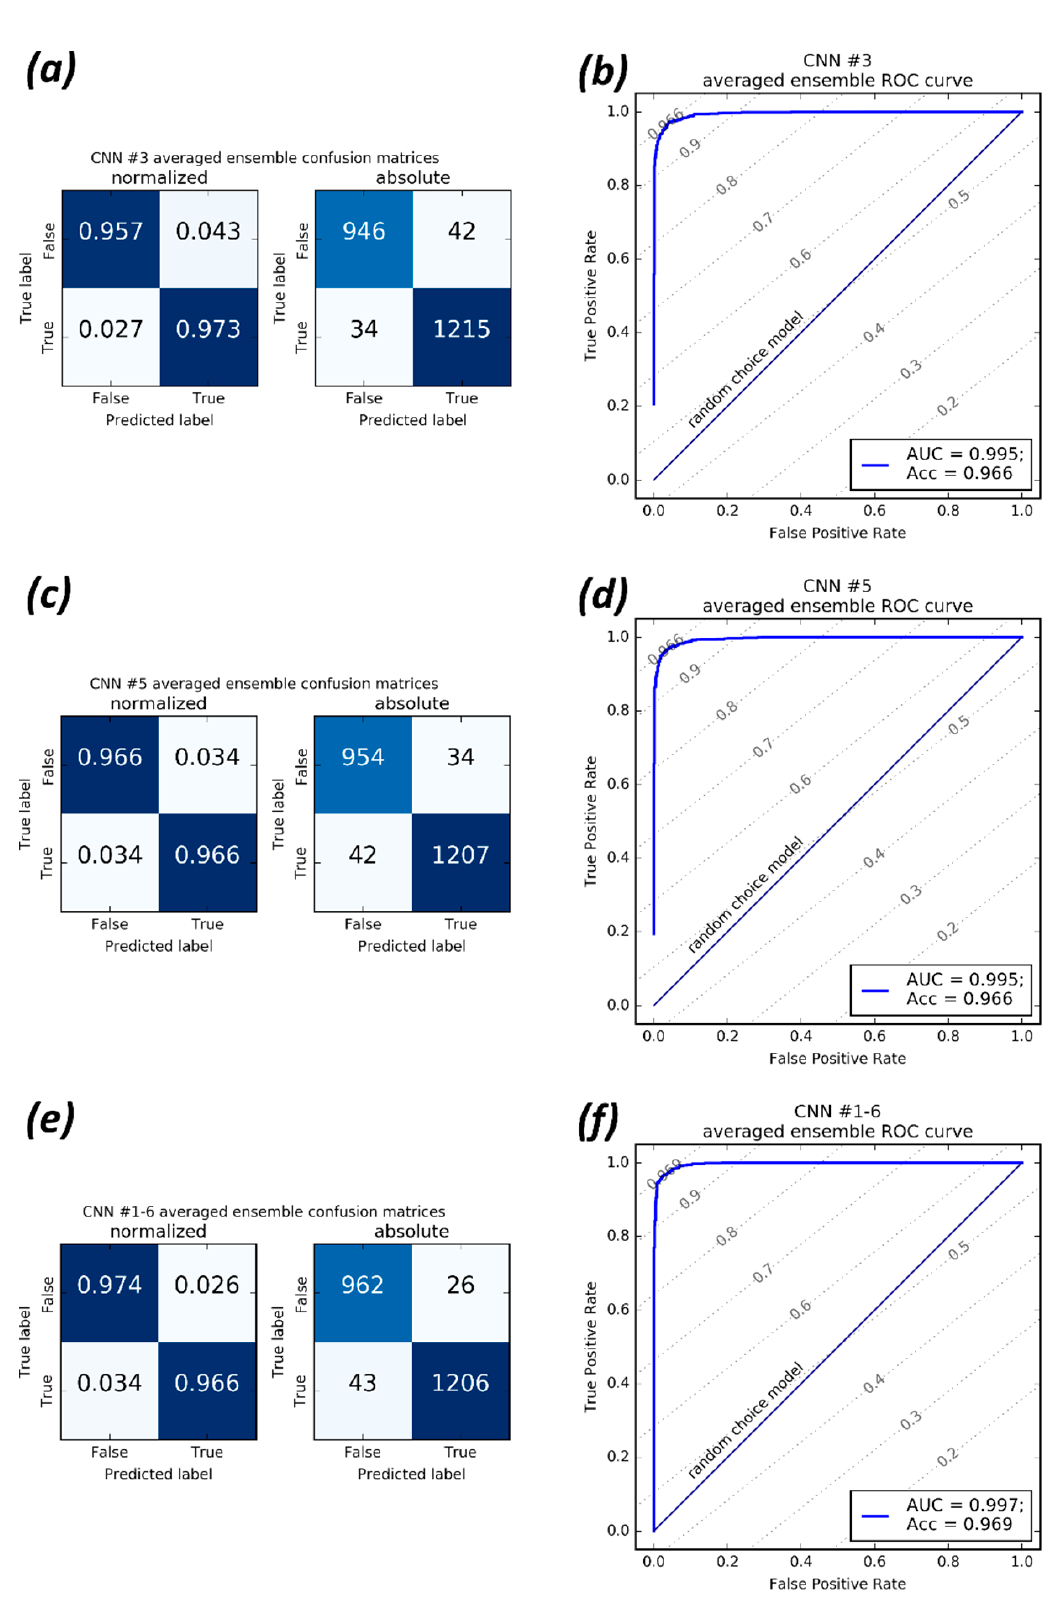
Figure 6. Confusion matrices and receiver operating characteristic curve for ( a , b ) CNN #3 and ( c , d ) CNN #5, both with the ensemble averaging approach applied (second-order models); and ( e , f ) third-order model CNN #1–6 averaged ensemble.